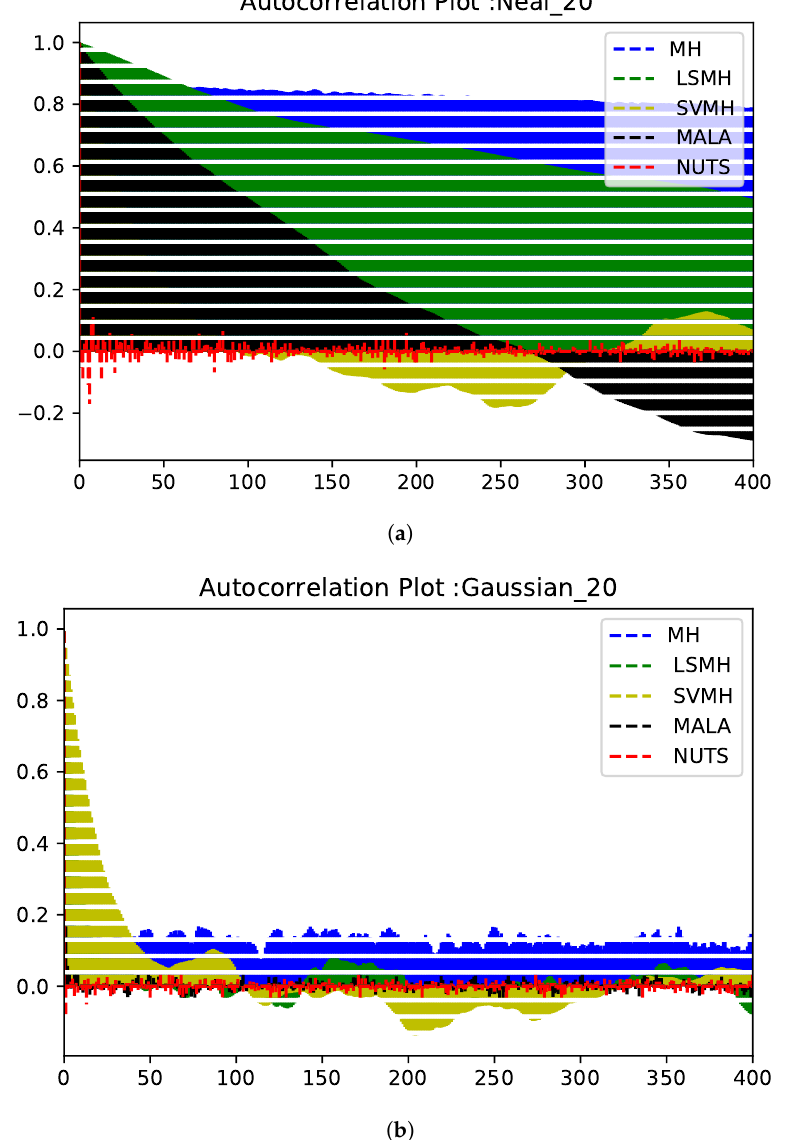
Figure 3. Autocorrelation plots for the first dimension across the various targets. These are autocor- relations from a single run of the MCMC chain. ( a ) Autocorrelation plot for the first dimension on the Neal funnel for D = 20 and ( b ) Autocorrelation plot for the first dimension on the multivariate Gaussian with D =